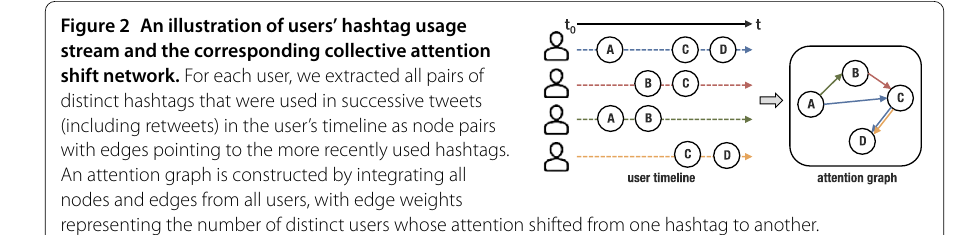
Figure 2 An illustration of users’ hashtag usage stream and the corresponding collective attention shift network. For each user, we extracted all pairs of distinct hashtags that were used in successive tweets (including retweets) in the user’s timeline as node pairs with edges pointing to the more recently used hashtags. An attention graph is constructed by integrating all nodes and edges from all users, with edge weights representing the number of distinct users whose attention shifted from one hashtag to